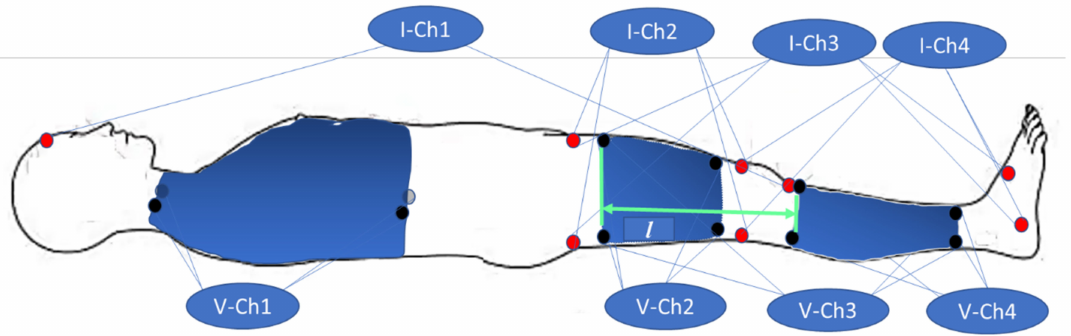
Figure 2. Electrode placement for transthoracic (Ch1), Thigh (Ch2), Whole leg (Ch3), and Lower leg